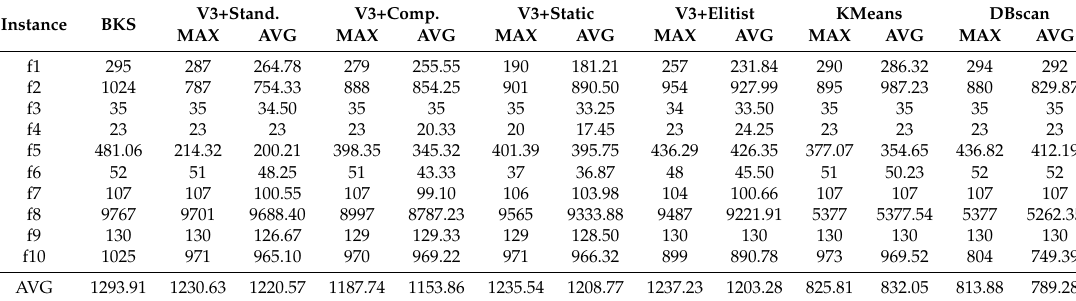
Table A18. CSA/KP—VShape 3—Two-steps vs. KMeans vs. DBscan.